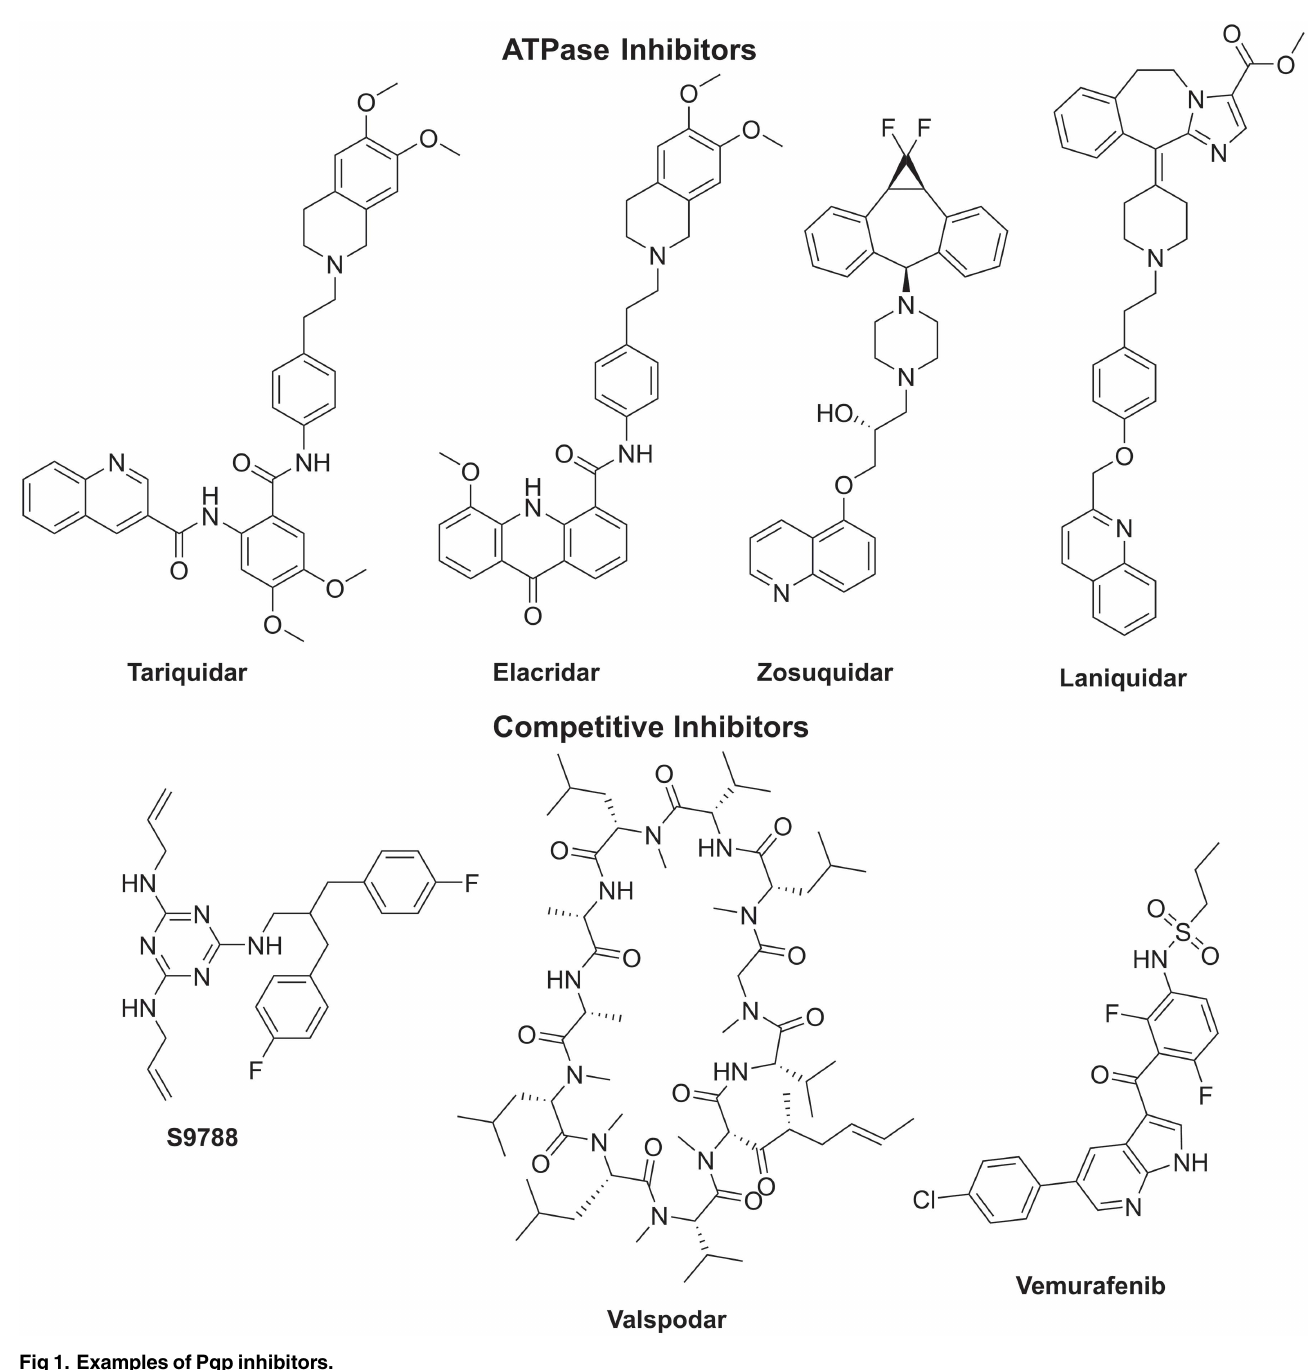
Fig 1. Examples of Pgp